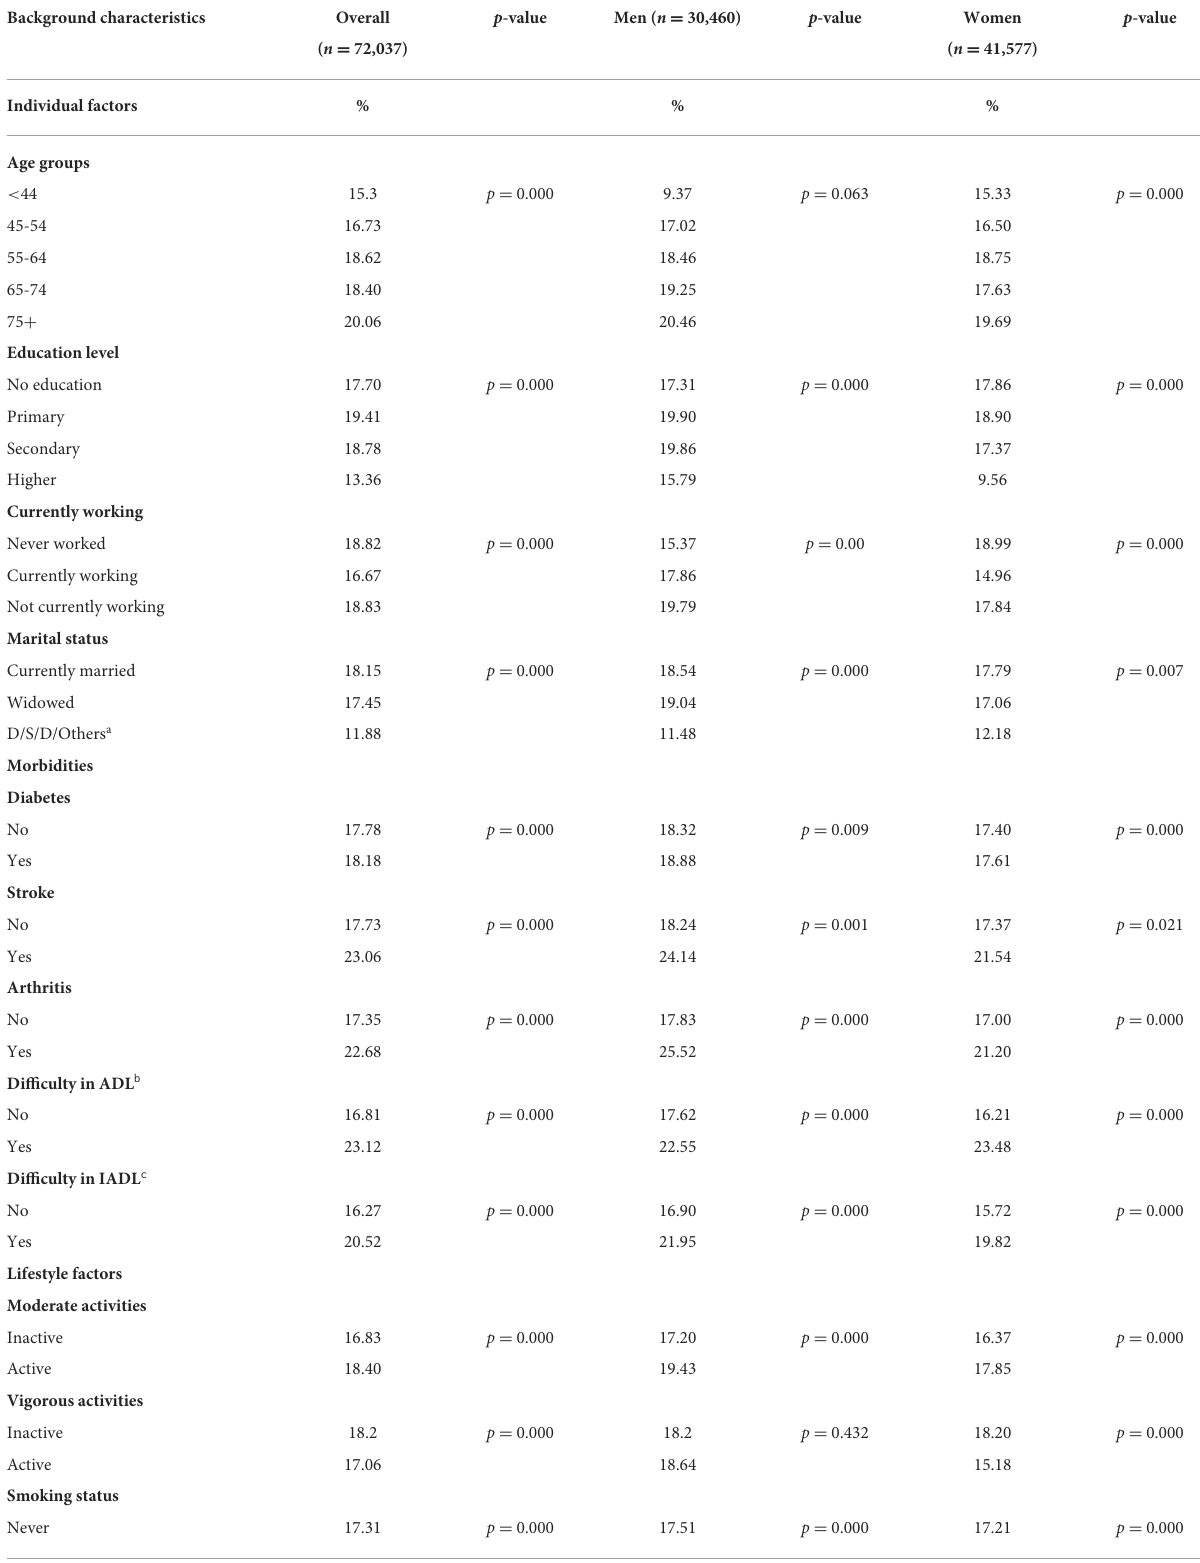
TABLE 2 Percentage of adults suffering from GI by their background characteristics in India, LASI 2017–18. Self-reported gastrointestinal